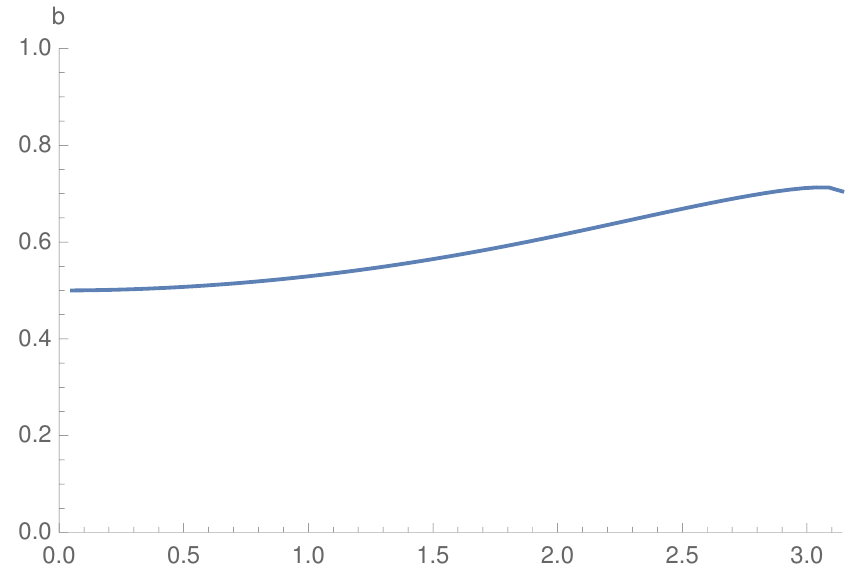
Figure 3. The scalar charge of the Skyrme-monopoles for (cid:23) 2 (0 ; (cid:25)